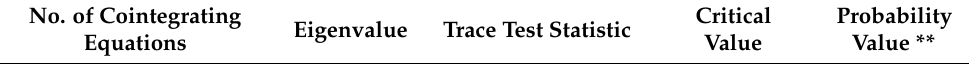
Table 8. Estimates of Johansen’s cointegration analysis of rice markets under structural break (Assumption: Linear deterministic trend).